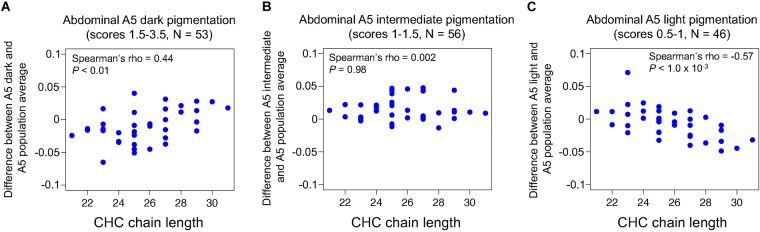
Abdominal pigmentation co-varies with CHC length profiles in the Drosophila Genetic Reference Panel (DGRP). Pigmentation scores and CHC data were obtained from Dembeck et al. (2015a,b). (A) Difference in log-contrast of relative CHC intensity between DGRP females with darkly pigmented fifth abdominal tergites (A5) (1.5 < score, N = 53) and the 155 line average. (B) Difference in log-contrast of relative CHC intensity between DGRP females with intermediately pigmented A5 (1 < score ≤ 1.5, N = 56) and the 155 line average. (C) Difference in log-contrast of relative CHC intensity between DGRP females with lightly pigmented A5 (score ≤ 1, N = 49) and the 155 line average.